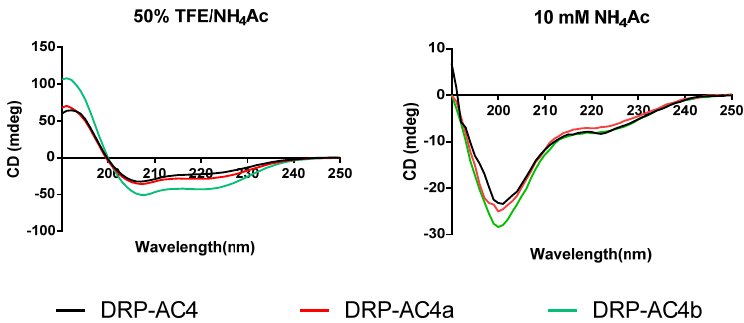
Figure 6. Circular dichroism spectra recorded for the three peptides (100 µ M), DRP-AC4 (black), DRP-AC4a (red) and DRP-AC4b (green), in 50% TFE/NH 4 Ac ( v / v ) ( left ) and 10mM NH 4 Ac buffer ( right ).